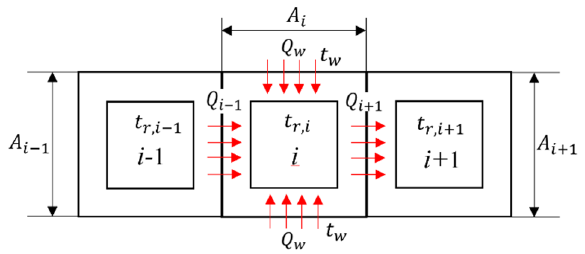
Figure 3. Heat transfer mechanism of a